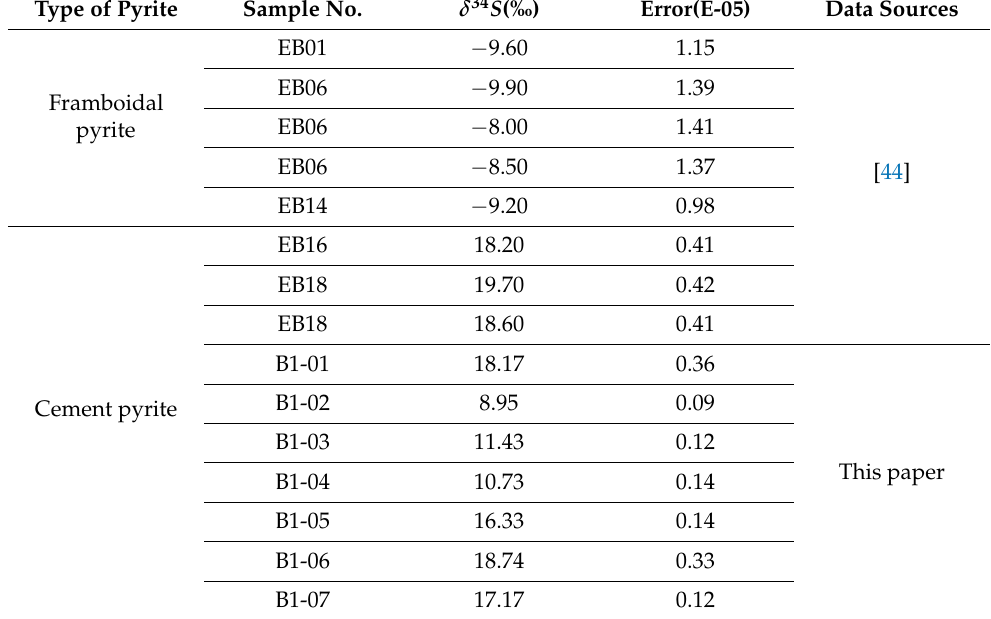
Table 2. In situ sulfur isotope analyses of different types of pyrite by LA–MC-ICP-MS in sandstone- hosted U deposits in northern Ordos